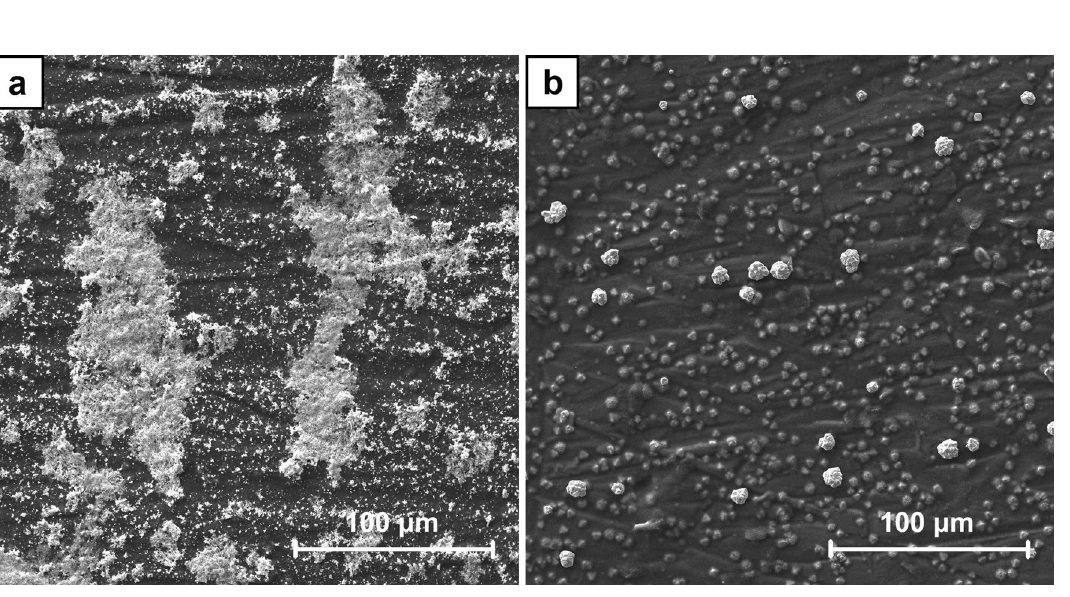
Figure 1. The comparison of SEM images of A7 sample (ECD deposition time of 600 s, CuSO 4 concentration of 1 mM) ( a ) and B7 sample (ECD deposition time of 600 s, CuSO 4 concentration of 100 mM) ( b ) at the magnification of